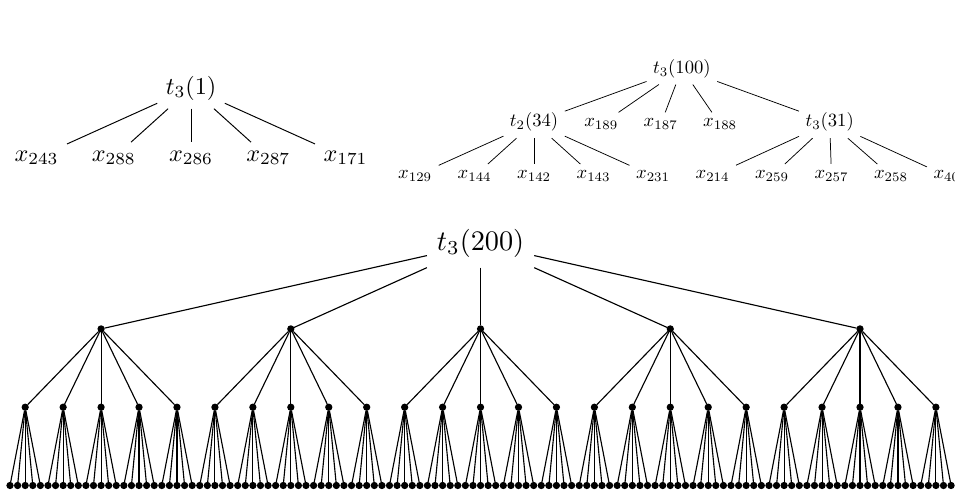
Figure 6: The strand trees T 3 (1), T 3 (100) and T 3 (200). T 3 (1), T 3 (200) are perfect. sponding to the unrolled strand equation t i ( r ). The child nodes of the strand T i ( r ) are therefore all the 5 nodes T j ( u ) for which the corresponding terms t j ( u ) are present in its recursive definition as per Definition